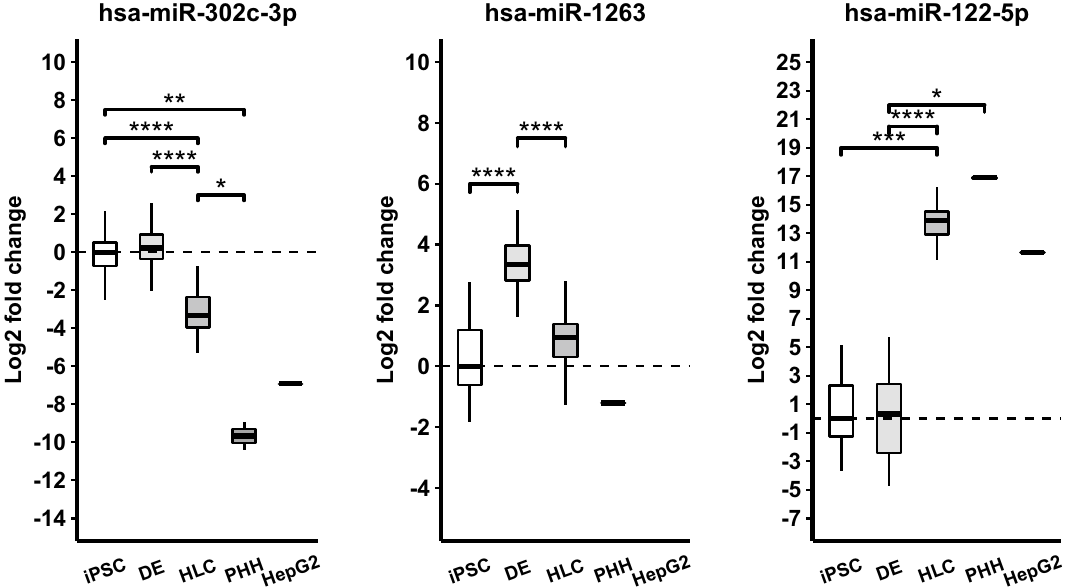
Figure 2. Validation of differentiation stage-specific miRNAs with RT-qPCR. miR-302c-3p, miR-1263 and miR- 122-5p have high expression in iPSCs, DEs and HLCs, respectively. Expression of miR-1263 was undetectable in HepG2 cells. Brackets represent p value of pairwise Mann–Whitney test: * p < 0.05, ** p < 0.01, *** p < 0.001, **** p < 0.0001. HepG2 cells were left out of pairwise